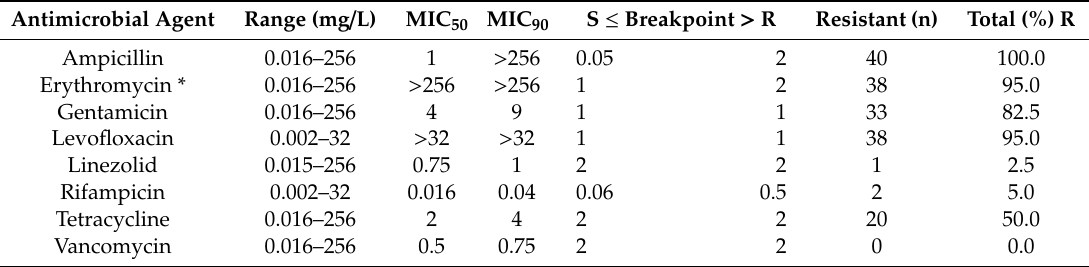
Table 1. Susceptibility of 40 Corynebacterium urealyticum clinical isolates against eight antimicrobial agents. Isolates were classified as resistant or susceptible according to criteria defined by EUCAST (2020). MIC, minimum inhibitory concentration; MIC 50 , MIC that inhibits 50% of the isolates; MIC 90 , MIC that inhibits 90% of the isolates. S , susceptible; R , resistant. * Staphylococcus spp. breakpoint. Antimicrobial Agent Range (mg / L)